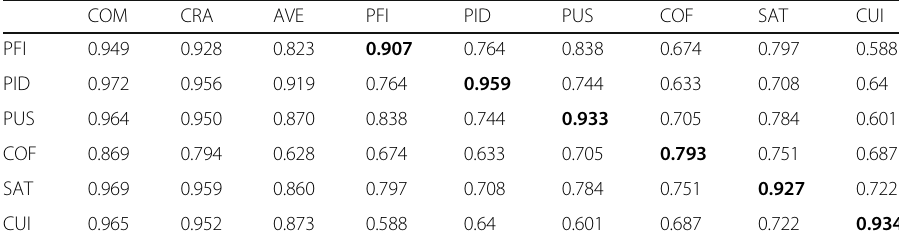
Table 3 Composite Reliability, Cronbach Alphas, AVEs, and inter-construct